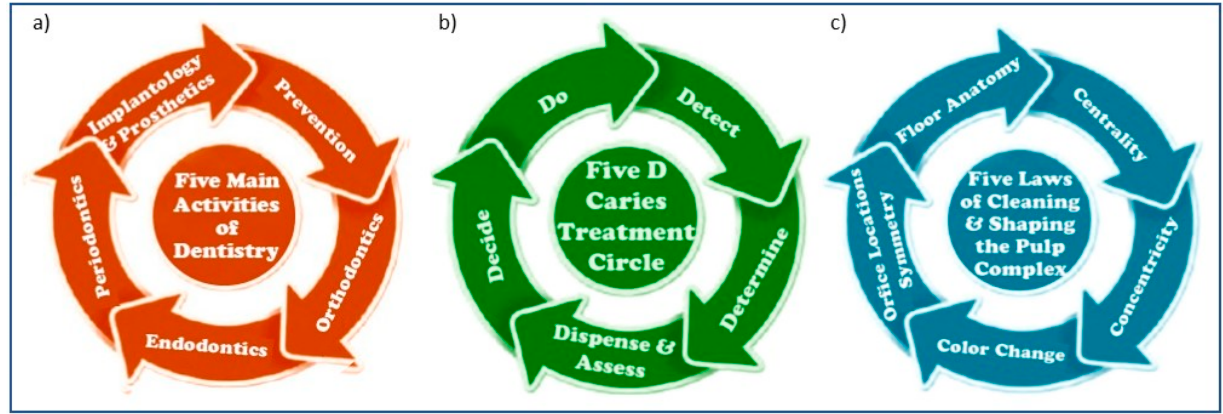
Figure 3. Diagram of the principles of the Fives: ( a ) Five Main Activities of Dentistry (5MAD); ( b ) Five D Caries Treatment Circle; ( c ) Five Laws of Cleaning and Shaping the Pulp Complex (5LCSPC).